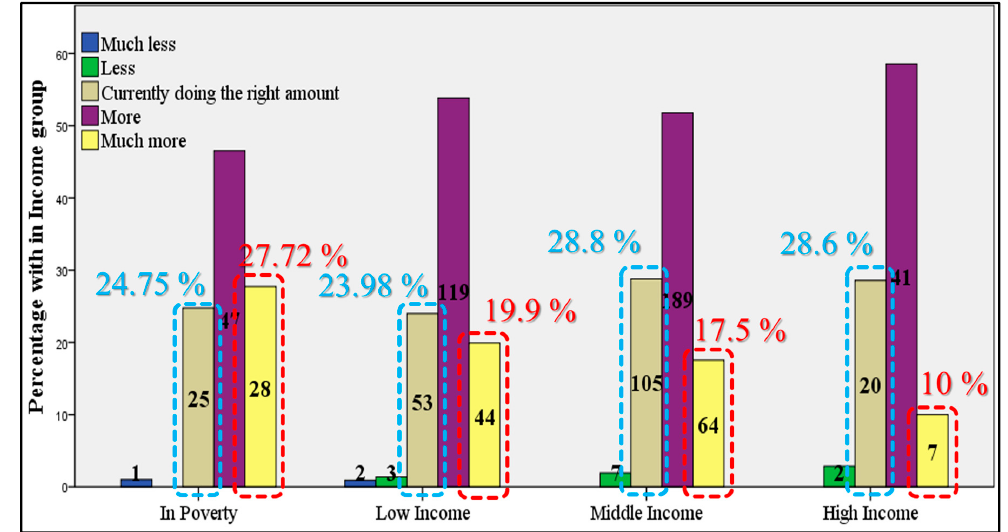
Figure 6. Different income groups expressions about citizens’ responsibility with regard to adaptation issues. The numbers inside the bars represent number of respondents.